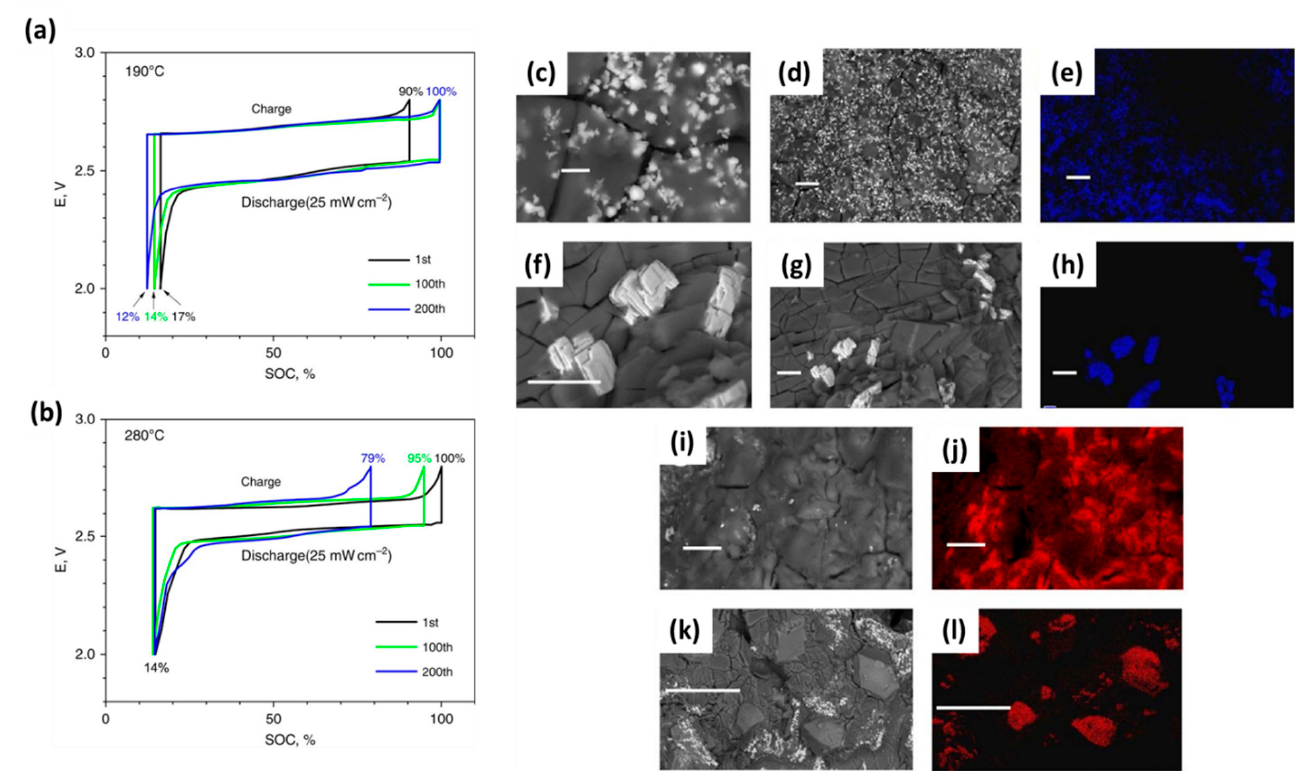
Figure 4. Voltage profiles for planar Na-NiCl 2 batteries operated at ( a ) 190 °C and ( b ) 280 °C. Cells were cycled with constant-current charge (7 mA/cm 2 , ~C/7) and constant-power discharge (25 mW/cm 2 , 10 mA/cm 2 , ~C/5). Cathode materials were retrieved from cells operated for 200 cycles at 25 mW/cm 2 and imaged via SEM with EDX mapping analysis ( c – l ). Ni particles are shown for cells operated at 190 °C ( c , d ) with corresponding EDX mapping of Ni ( e ), and then at 280 °C ( f , g ) with corresponding mapping of Ni ( h ). Below, NaCl particles are shown for cells operated at 190 °C ( i ) with corresponding EDX mapping of Na ( j ), and then at 280 °C ( k ) with corresponding EDX mapping of Na ( l ). Scale bars are 2 m for ( c ), 10 µm for ( d – j ), 100 µm for ( k , l ; adapted with the permission from Springer Nature).